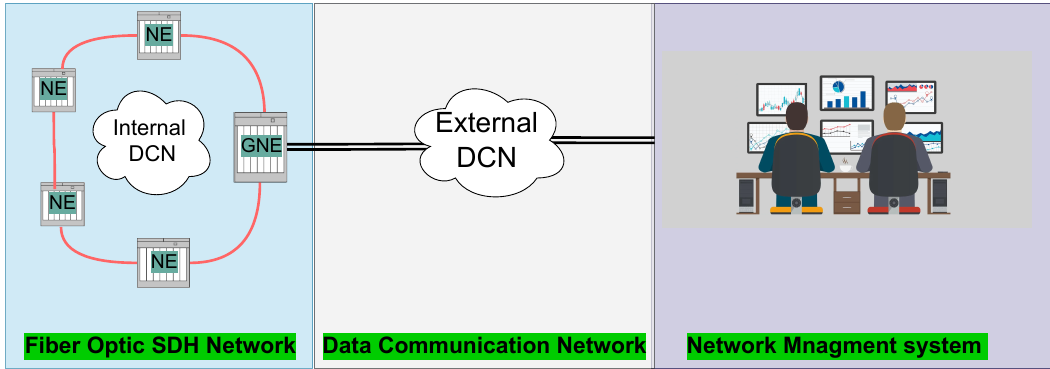
Figure 2. Fiber optic network architecture.